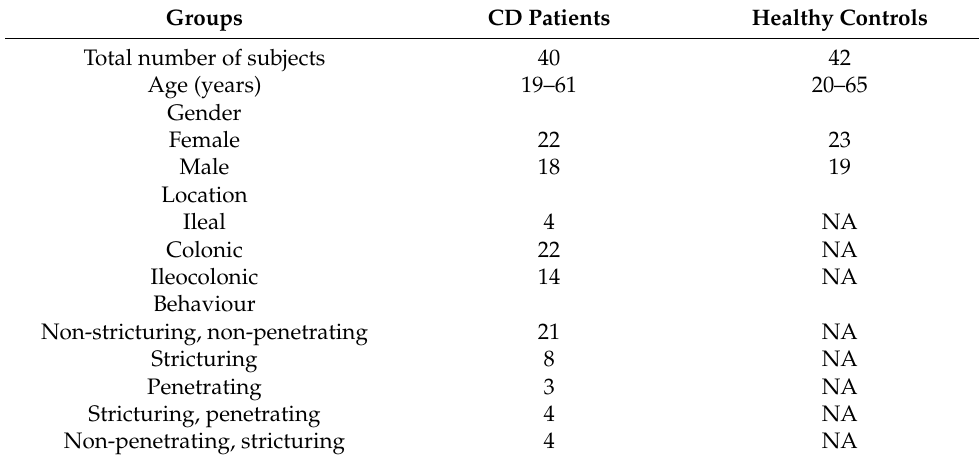
Table 1. Patient